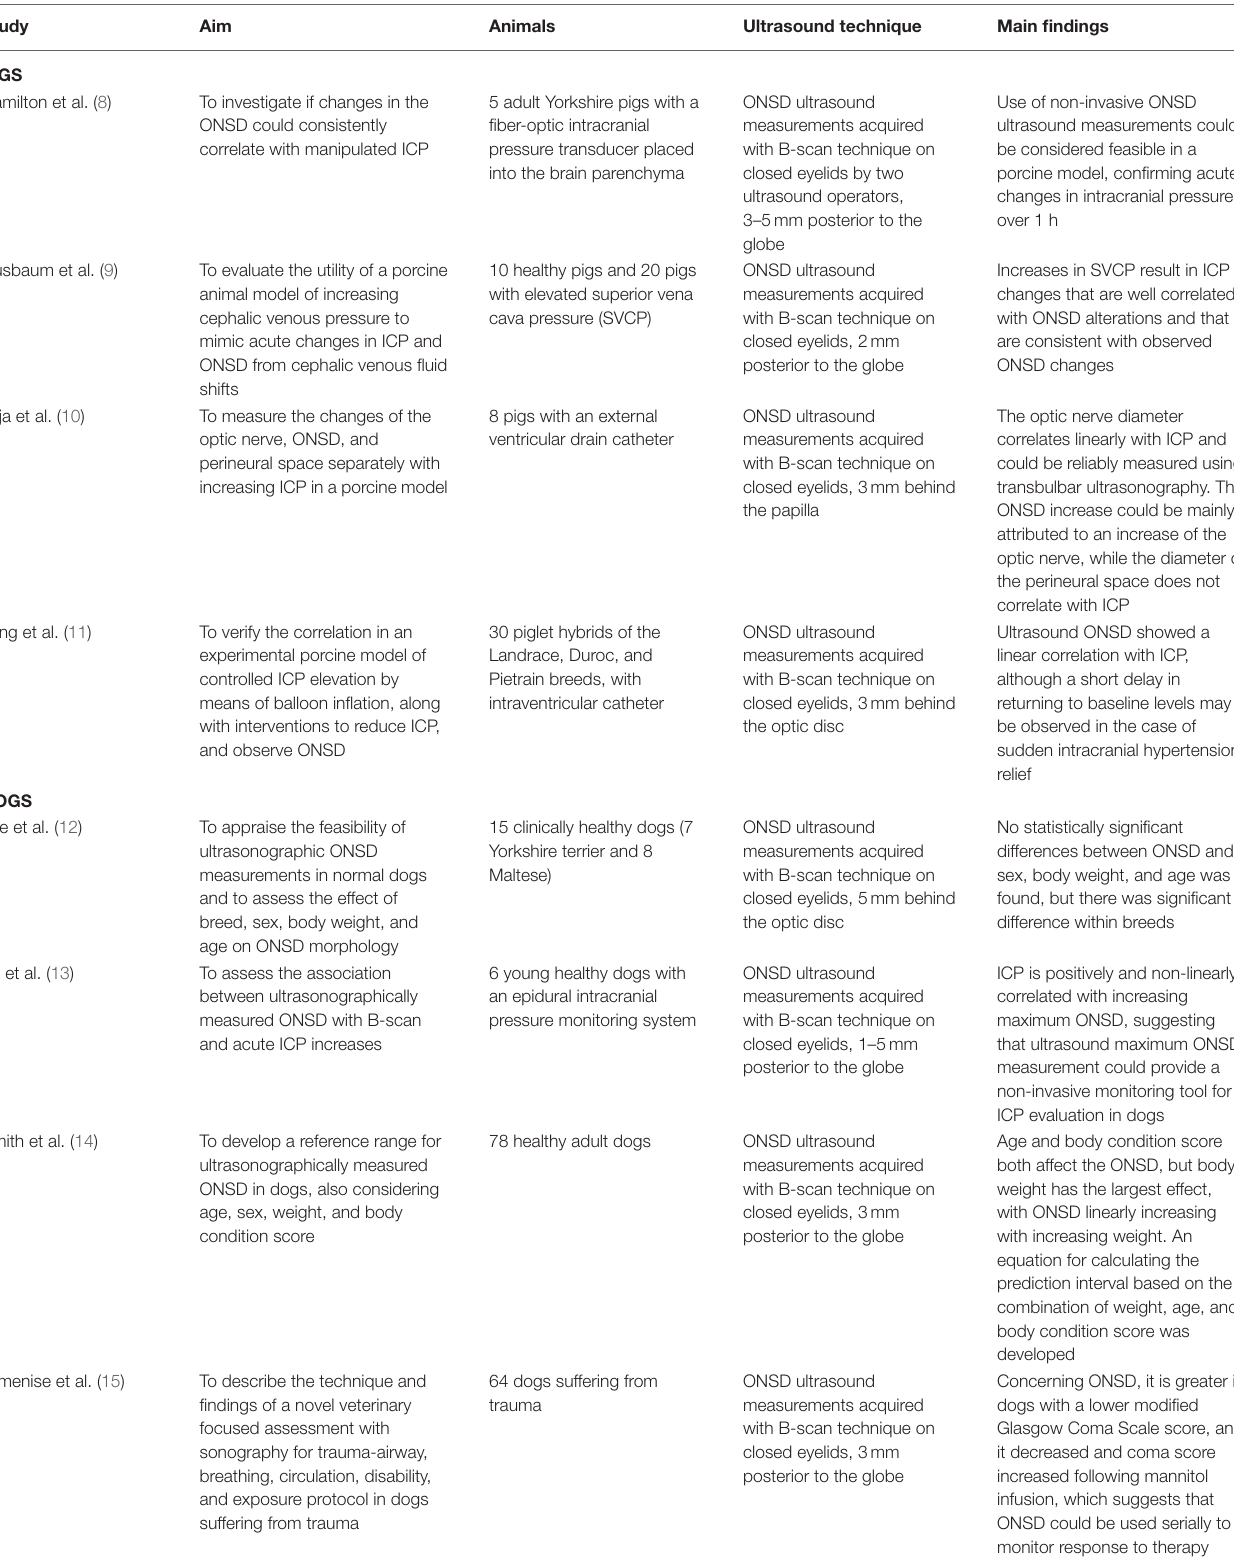
TABLE 1 | Summary of published articles on ONSD ultrasound evaluation in animal